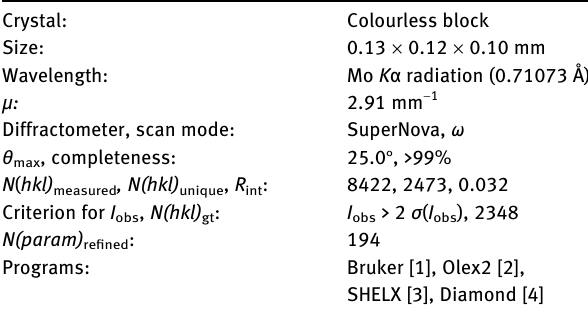
Table  : Data collection and